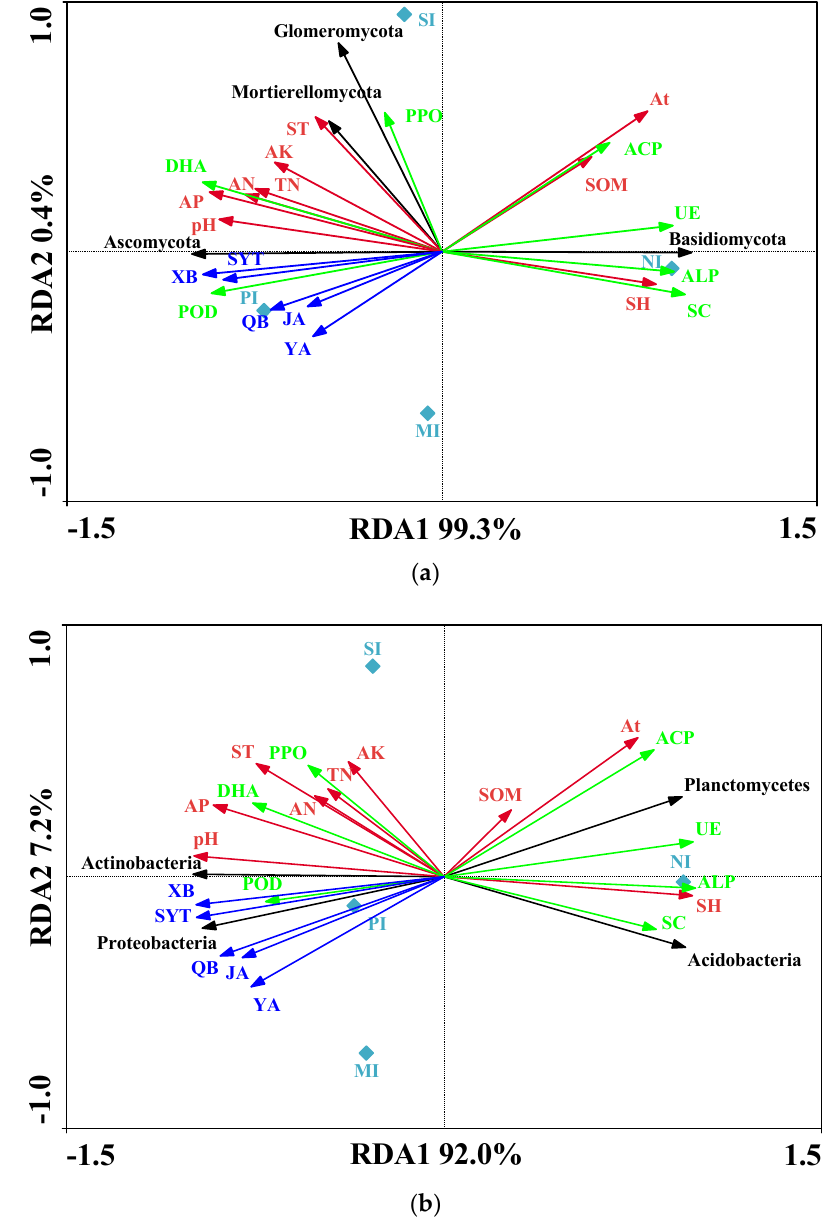
Figure 6. Redundancy analysis (RDA) of fungi ( a ) and bacteria ( b ). The red arrow and the green arrow represent the relative position of soil physical and chemical properties and enzyme activity on the horizontal plane; the blue arrow represents the relative position of soil allelochemicals on the horizontal plane. The black arrow represents the species distribution at the phylum level, and the longer the arrow, the greater the impact of the species in the sample. Where the angle between the arrow and the sort axis is different, the correlation strength is also different. The smaller the angle, the greater the correlation, and, the longer the length of the arrow, the greater the effect of the environmental factor. Note: pH, hydrogen ion concentration; At, altitude; ST, soil temperature; SH, soil humidity; SOM, soil organic matter; TN, total nitrogen; AN, alkali-hydrolyzable nitrogen; AK, available potassium; AP, available phosphorous; PPO, polyphenol oxidase; POD, peroxidase; UE, urease; DHA, dehydrogenases; SC, sucrase; ALP, alkaline phosphatase; ACP, acid phosphatase; SYT, chamaechromone; YA, mesoneochamaejasmin A; XB, neochamaejasmin B; QB, dihydrodaphnodorin B; JA, 7-methoxyneochamaejasmine A; NI, no invasion; PI, primary invasion; MI, moderate invasion; SI, severe